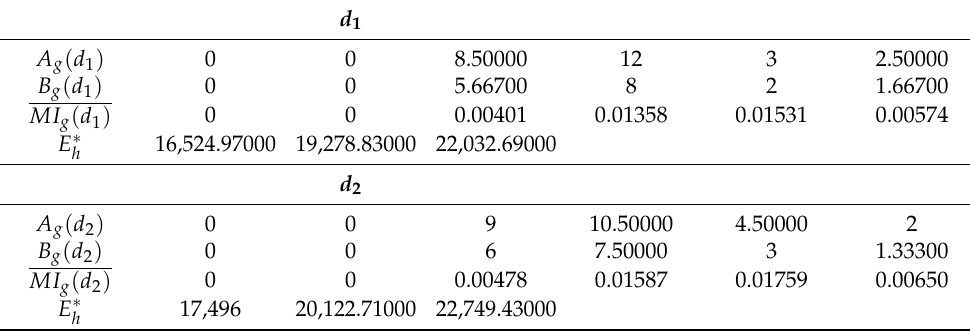
Table 1. Numerical results of Example